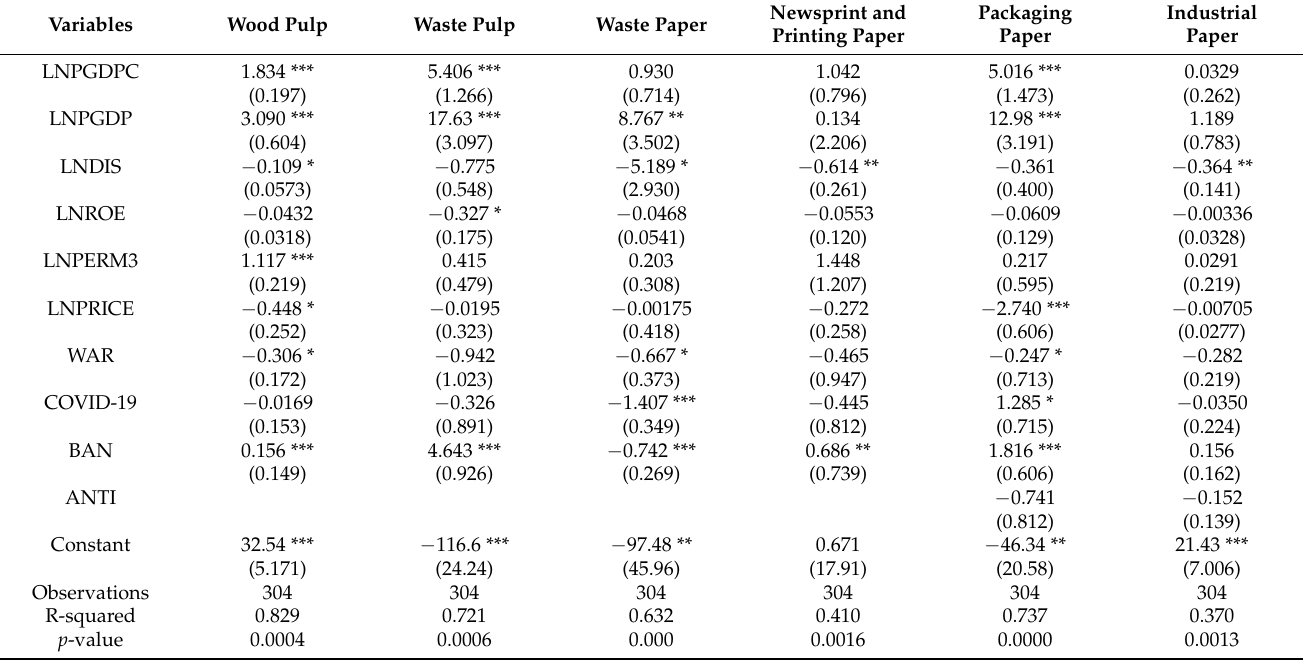
Table 4. Results of pulp and paper product